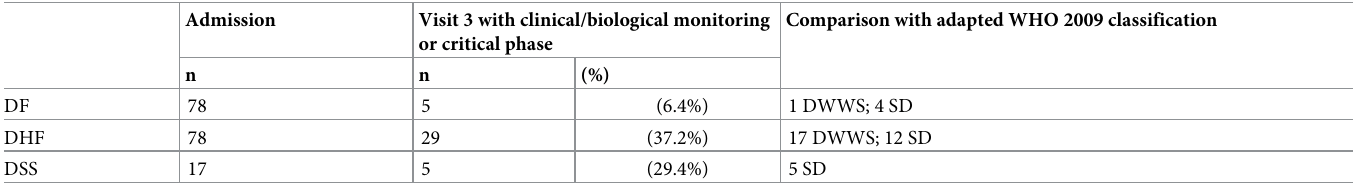
Table 5. Distribution of dengue patients in the critical phase at Visit 3 with follow-up, with respect to their WHO 1997 and adapted WHO 2009 dengue classifications. Admission Visit 3 with clinical/biological monitoring Comparison with adapted WHO 2009 or critical phase